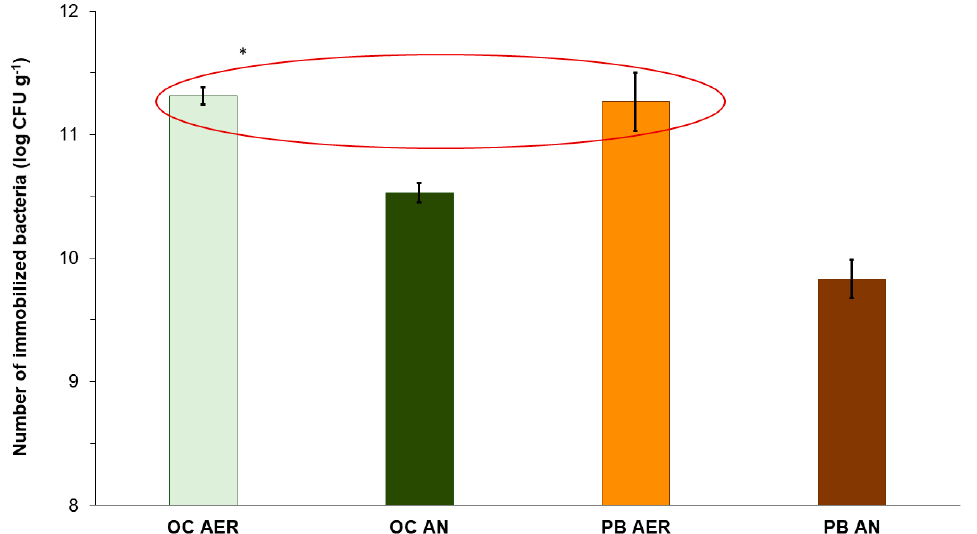
Figure 3. The numbers of bacteria immobilized onto perlite in the setup with aeration and OC (OC AER), aeration and PB (PB AER), or in anaerobic conditions with mixing and OC (OC AN) and PB (PB AN), respectively. * the values that do not differ significantly ( p < 0.05) are circled.